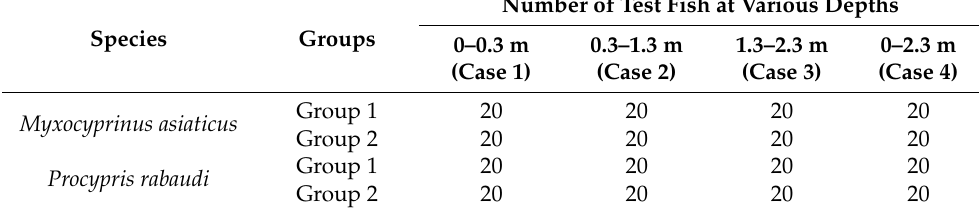
Table 1. Experimental